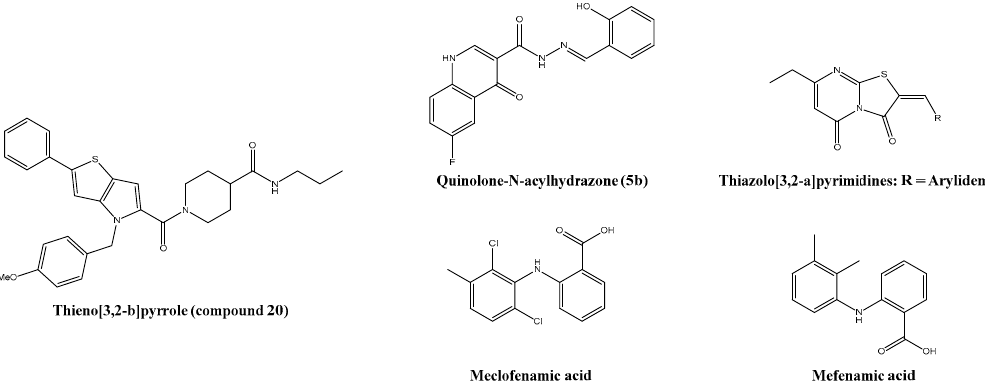
Figure 6. Chemical structure of anti-CHIKV compounds without known target. Table 4. Antiviral compounds without a known target. a